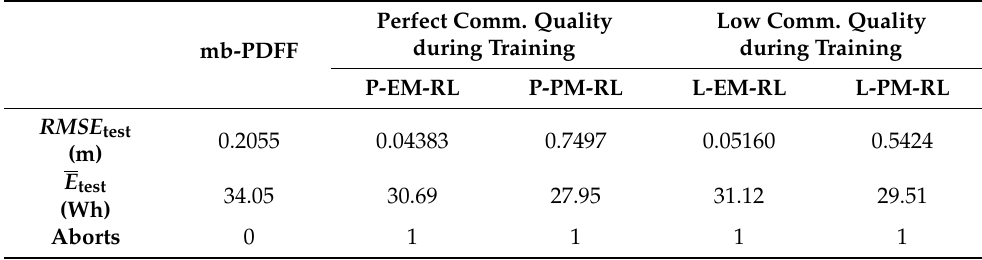
Table 5. mb-PDFF and RL-agent-based CACC performance on test set. Perfect communication quality is available during evaluation and the RL agents use a prediction horizon of N k = 1. The test set consists of 93 trajectories. Perfect Comm. Quality Low Comm. Quality during Training during mb-PDFF